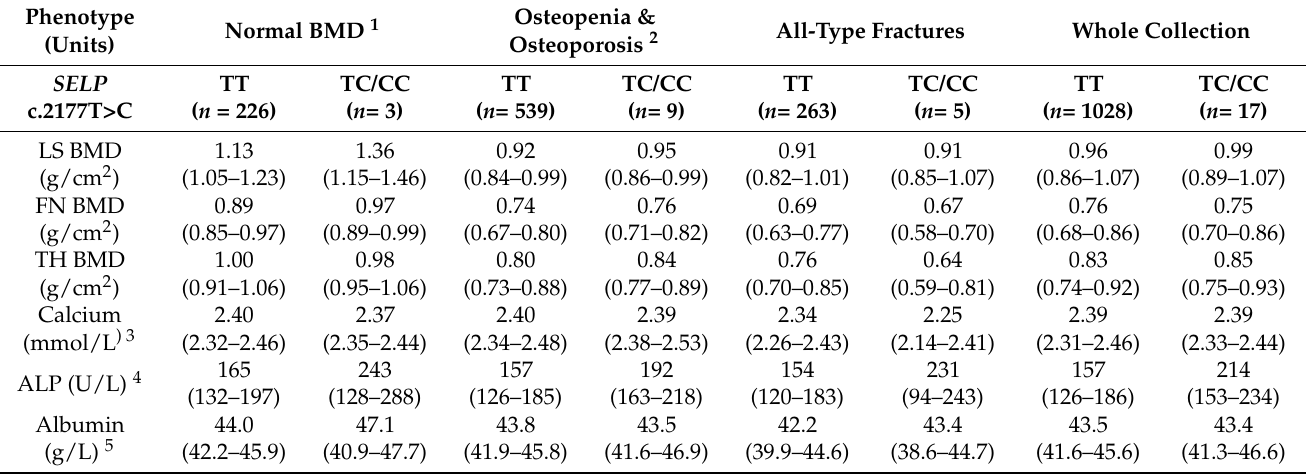
Table 5. Levels of bone-related phenotypic measurements according to the three genotyped variants in